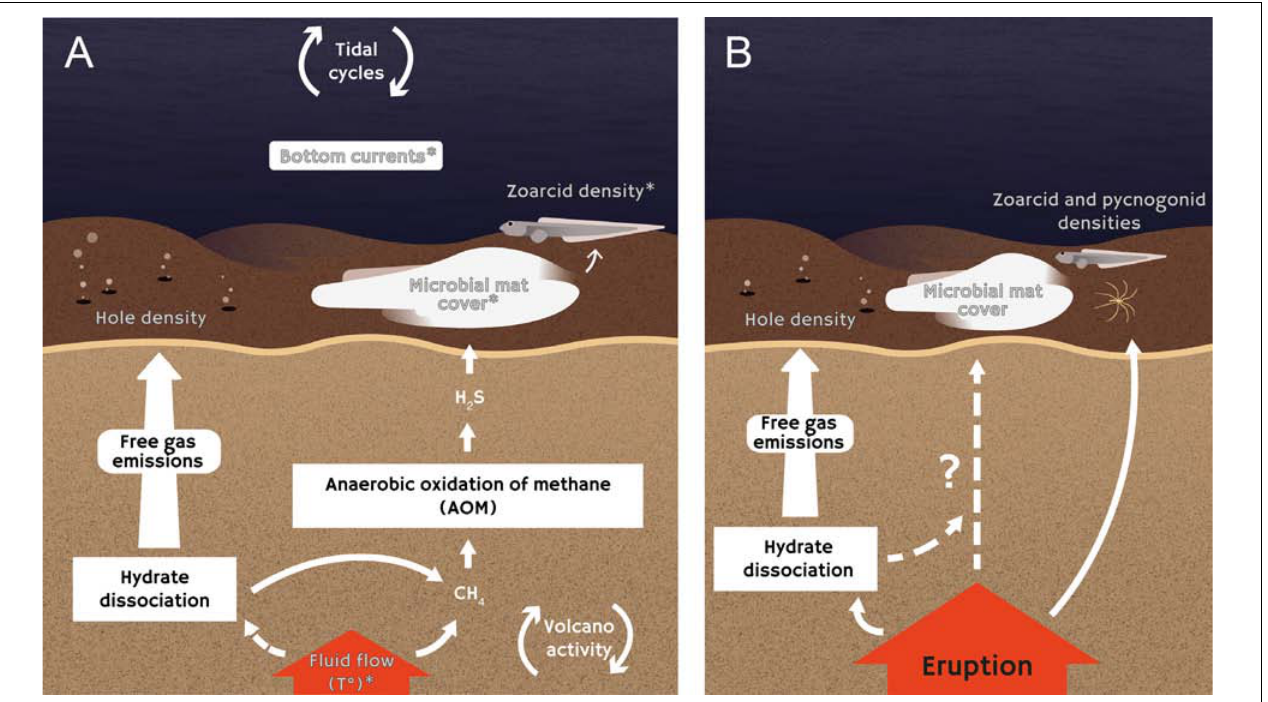
FIGURE 7 | Schematic representation of inferred interactions between fauna, microbial activity, porewater biogeochemistry, and fluid flows at Håkon Mosby mud volcano microbial mat habitats. (A) Interactions inferred from of the analysis of time series of data collected before the eruption and (B) the impacts of the mud eruption on faunal density, microbial activity, and environmental variables are represented separately. White arrows represent positive relationships, and variables analyzed in this study are shown in gray. Variables related to cyclic common trends are indicated by an asterisk ( ∗